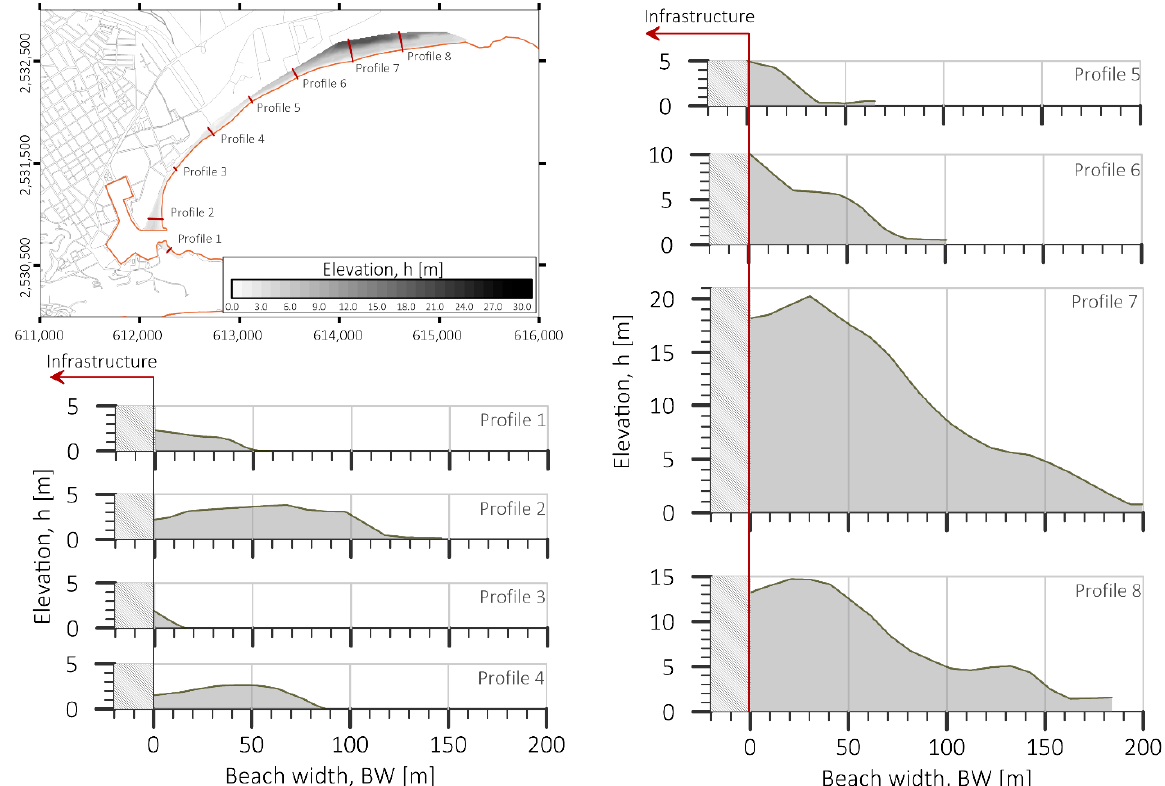
Figure 6. Beach profiles within San Lucas Bay, limited landward by infrastructure (e.g., hotels, restaurants, shopping centers, roadways).